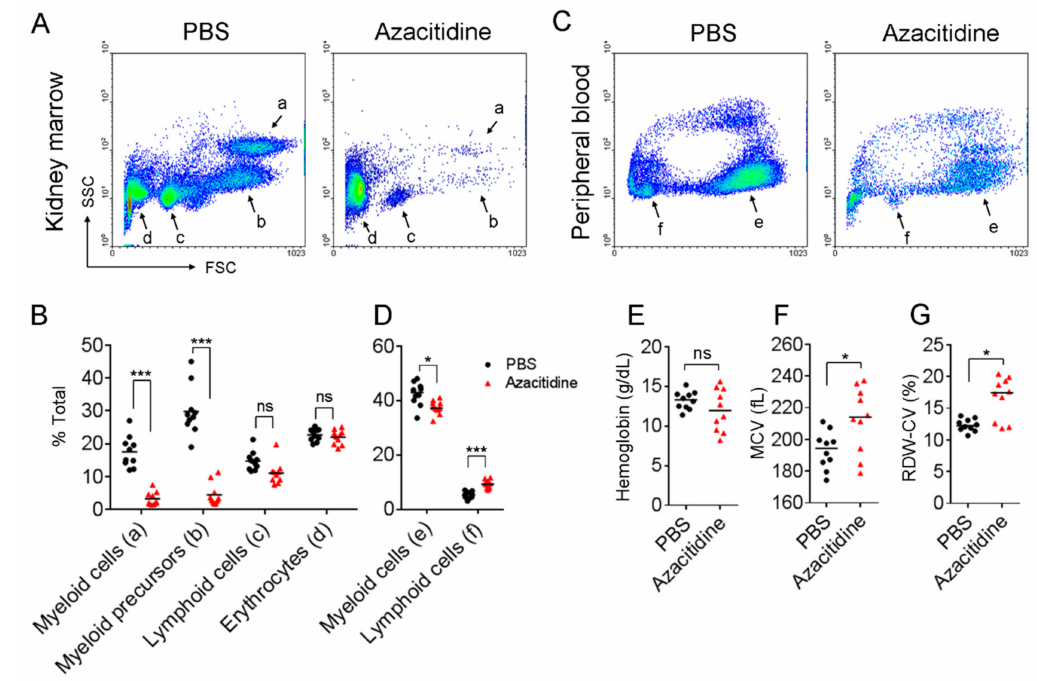
Figure 1. Marked myelosuppression induced by azacitidine in zebrafish. Dot-plot representation of ( A ) whole kidney marrow (WKM) and ( B ) peripheral blood cells isolated from phosphate-bu ff ered saline (PBS)- and azacitidine-treated zebrafish analyzed by flow cytometry. The relative percentage of subpopulations as indicated were measured and presented as median in ( C , D ); each dot in the plot represents the percent gated area; n = 10. The hemoglobin concentration ( E ), mean corpuscular volume (MCV) ( F ) and red cell distribution width-coe ffi cient of variation (RDW-CV) ( G ) were measured by an automated blood analyzer. n = 10. * p < 0.05, *** p < 0.001, ns, not significant, by the Mann–Whitney U